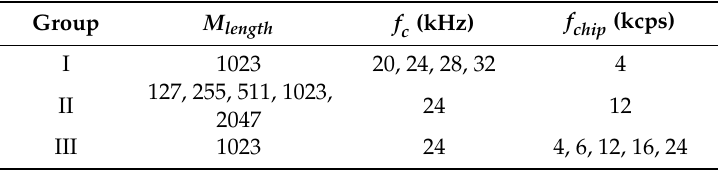
Table 1. SSSound pairs for